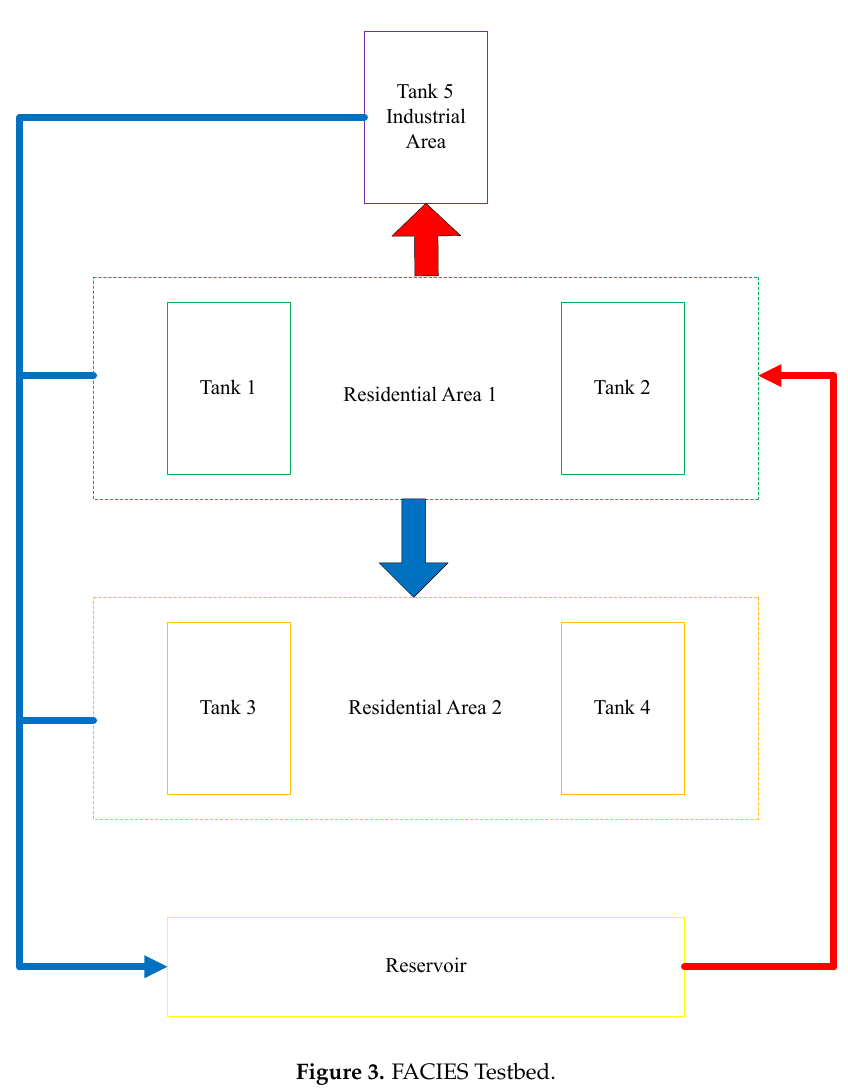
Figure 3. FACIES Figure 3. FACIES Testbed.